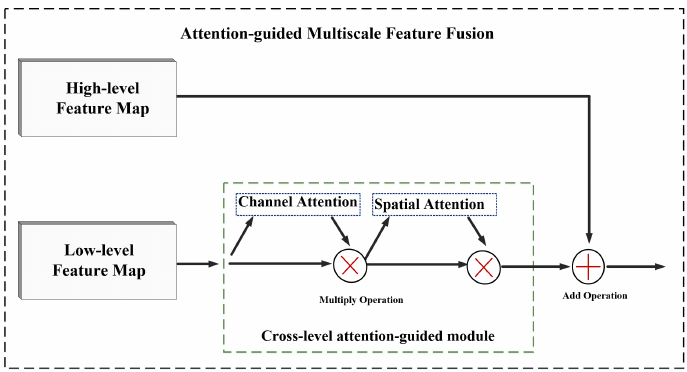
Figure 4. An example of cross-level attention-guided